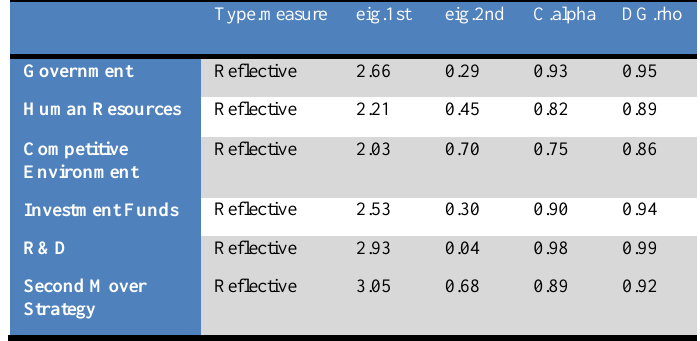
Table 2: Outer Model